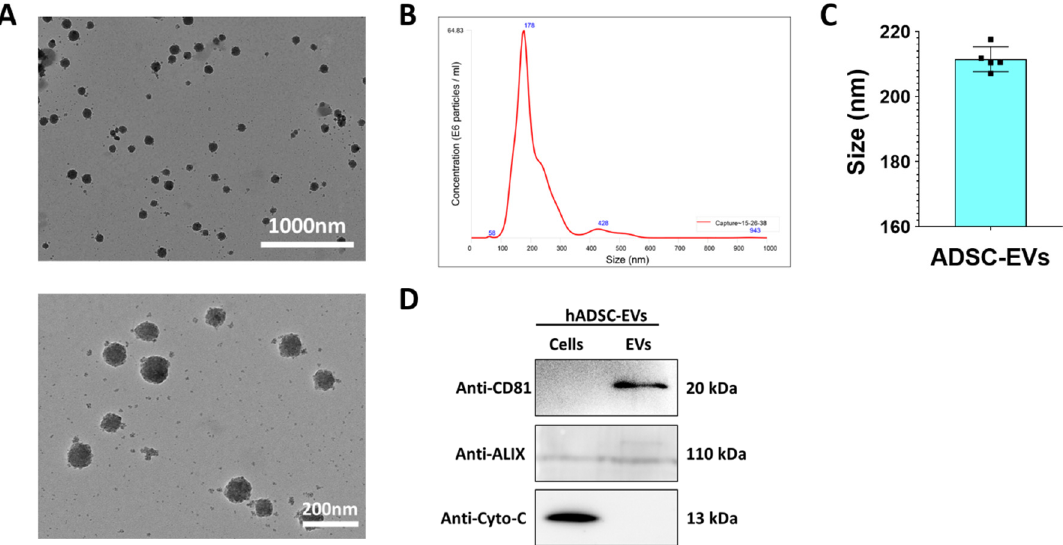
Figure 2. Characterization of the ADSC EVs. ( A ) Morphology of human primary ADSC EVs confirmed by TEM (scale bar: 1000 and 200 nm). ( B , C ) NTA of the ADSC EVs ( n = 5). The results are expressed as the mean ± SD. ( D ) Western blot analysis of the ADSCs and ADSC EVs, for which anti-CD81, anti-ALIX, and anti-cytochrome c antibodies were used.